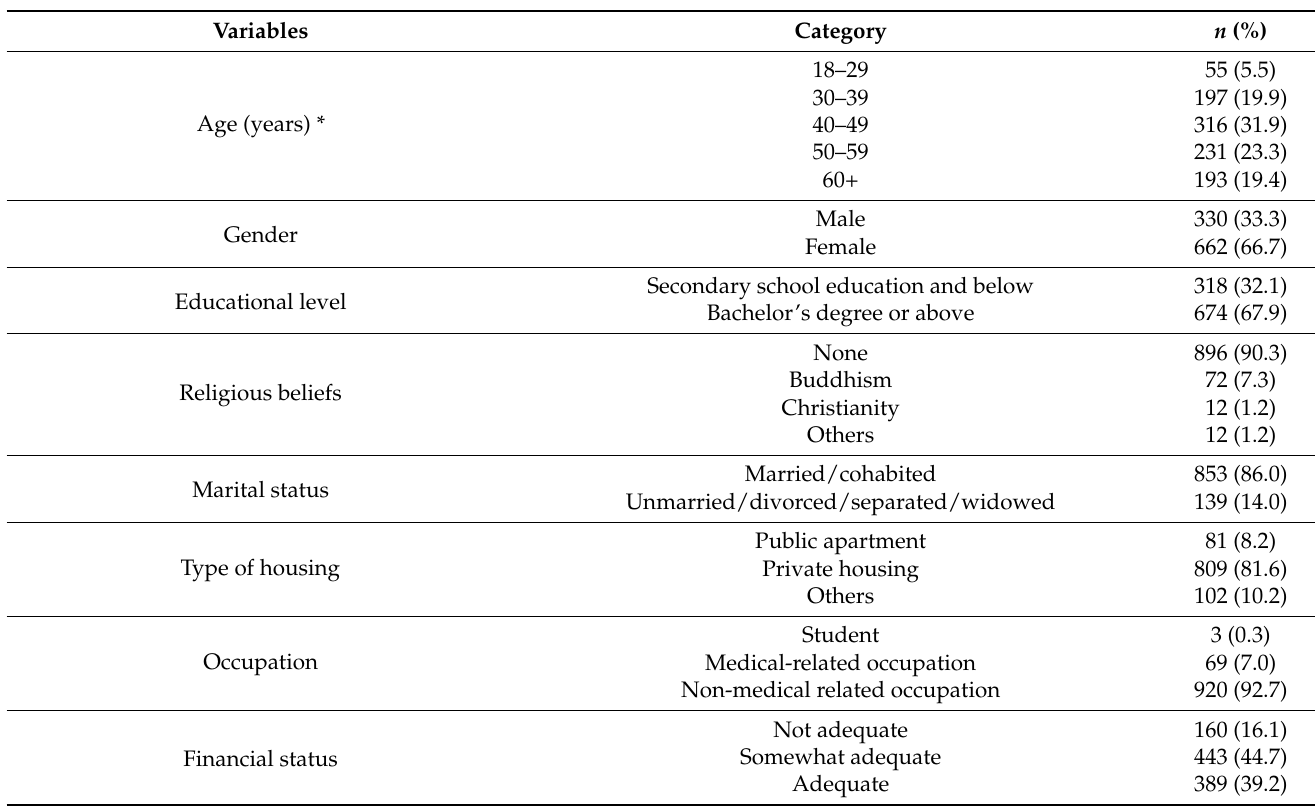
Table 1. Characteristics of participants ( n =